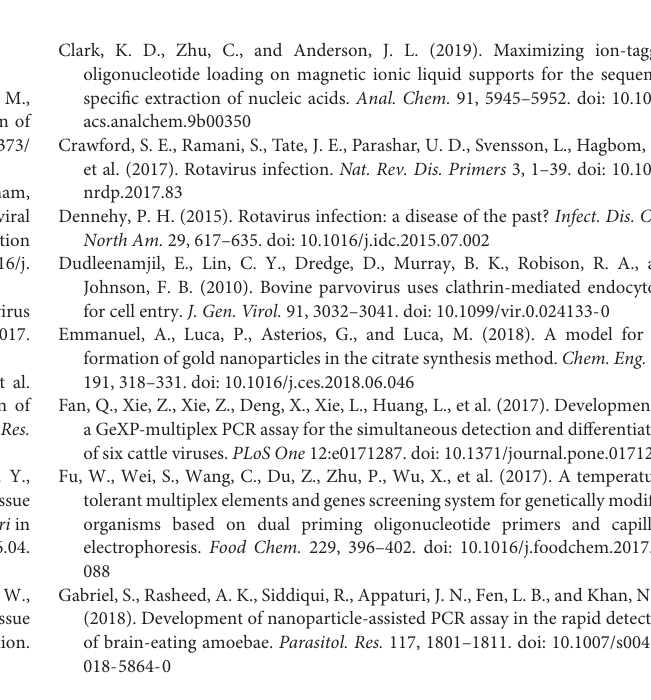
FIGURE S1 | Reproducibility test results. The reproducibility of DPO-nanoPCR assay was evaluated by testing different concentrations of standard plasmids. Each dilution was analyzed in three independent experiments performed by two different operators (A,B) . A serial 10-fold diluted plasmid mixture was used. Lane M, DL2000 DNA marker. (A1,B1) Lane 1–11, pMD19-T-VP6 concentrations ranging from 9.40 × 10 10 copies/ µ L to 9.40 × 10 0 copies/ µ L, pMD19-T-VP2 concentrations ranging from 5.14 × 10 10 copies/ µ L to 5.14 × 10 0 copies/ µ L, and pMD19-T-5 (cid:48) UTR concentrations ranging from 4.09 × 10 11 to 4.09 × 10